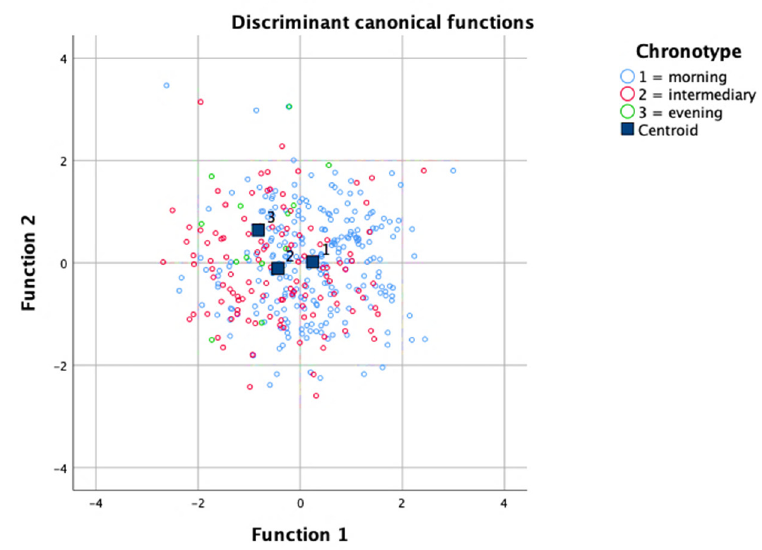
Figure 2. Graphical analysis of the discriminatory power of the two functions and centroids of the three groups. Function 1 (X axis) discriminates better between the morning chronotype (CT) (blue dots) and the other groups, as its mean is reasonably different from the others, while Function 2 (Y axis) helps to discriminate between evening CT (green dots) and the other two groups. Function 1 explained 87% of the variance ( p = 0.001) (Box’s M statistic: p = 0.545).